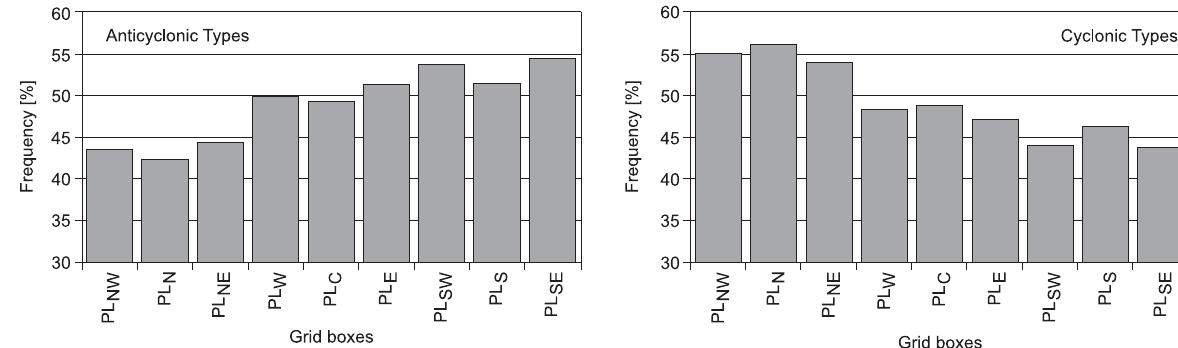
Fig. 3. Frequency of antycyclonic and cyclonic circulation types in winter (DJF) for grid box within Poland. PL